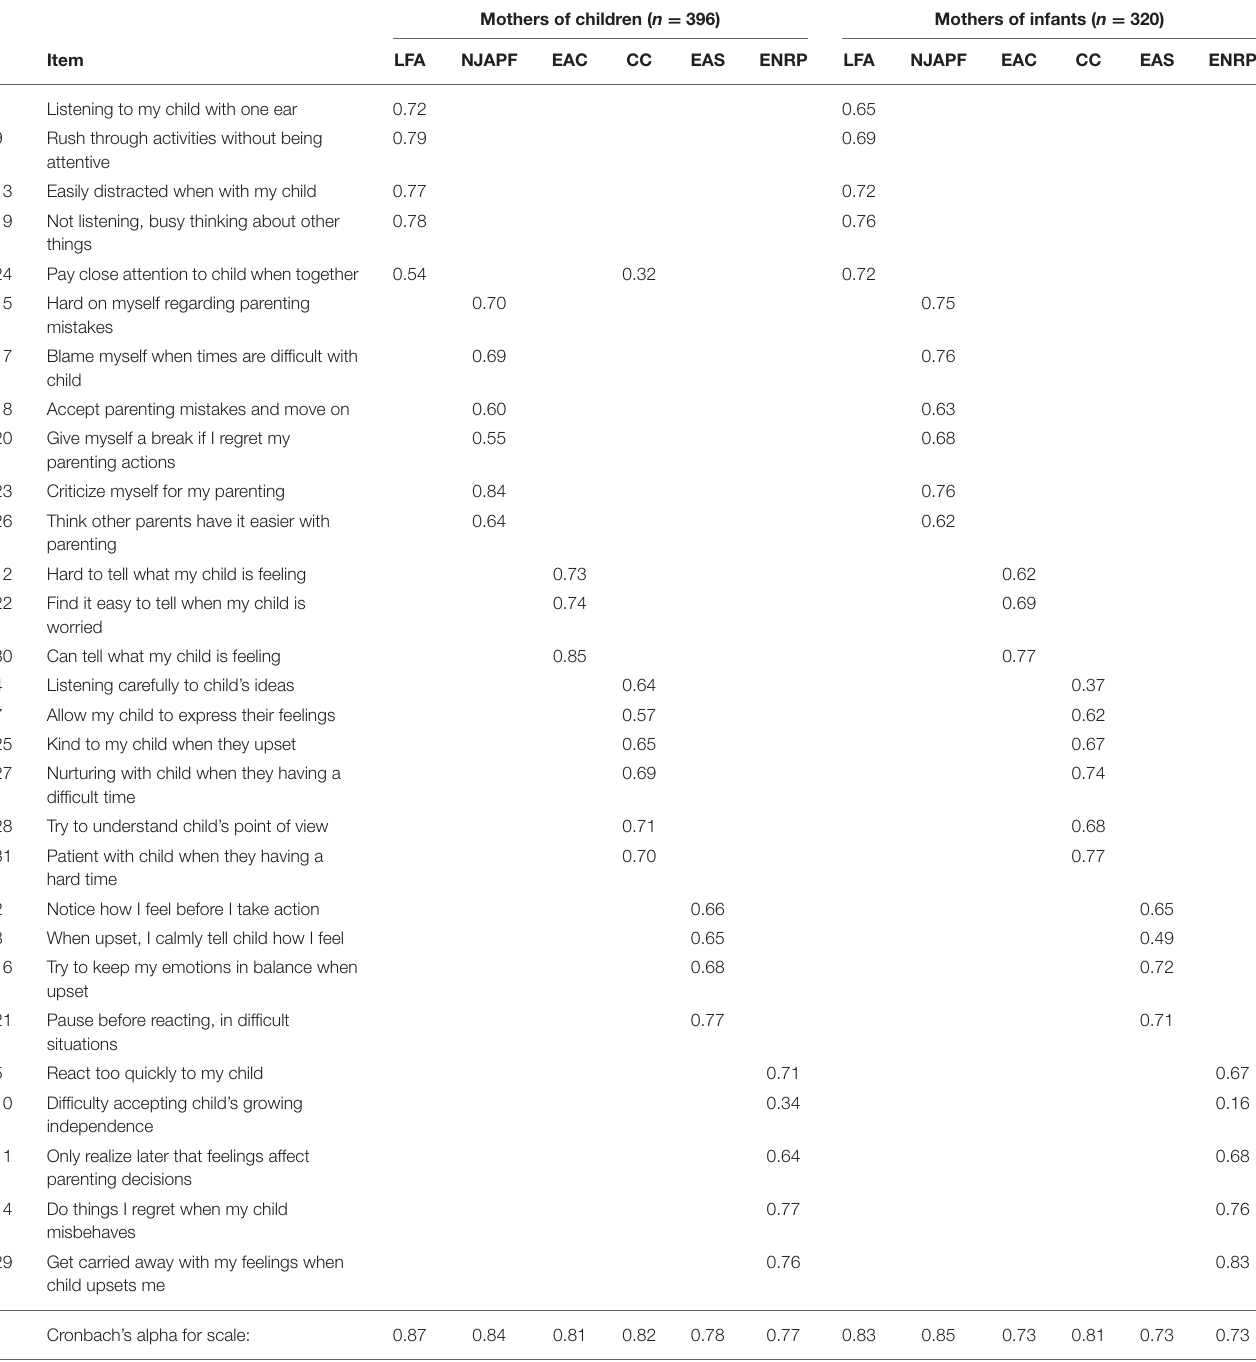
TABLE 4 | Standardized factor loadings for 29-item de Bruin et al. (2014) model, for mothers of children (Model C.5) and infants (Model I.5). Mothers of children ( n = 396) Mothers of infants ( n =